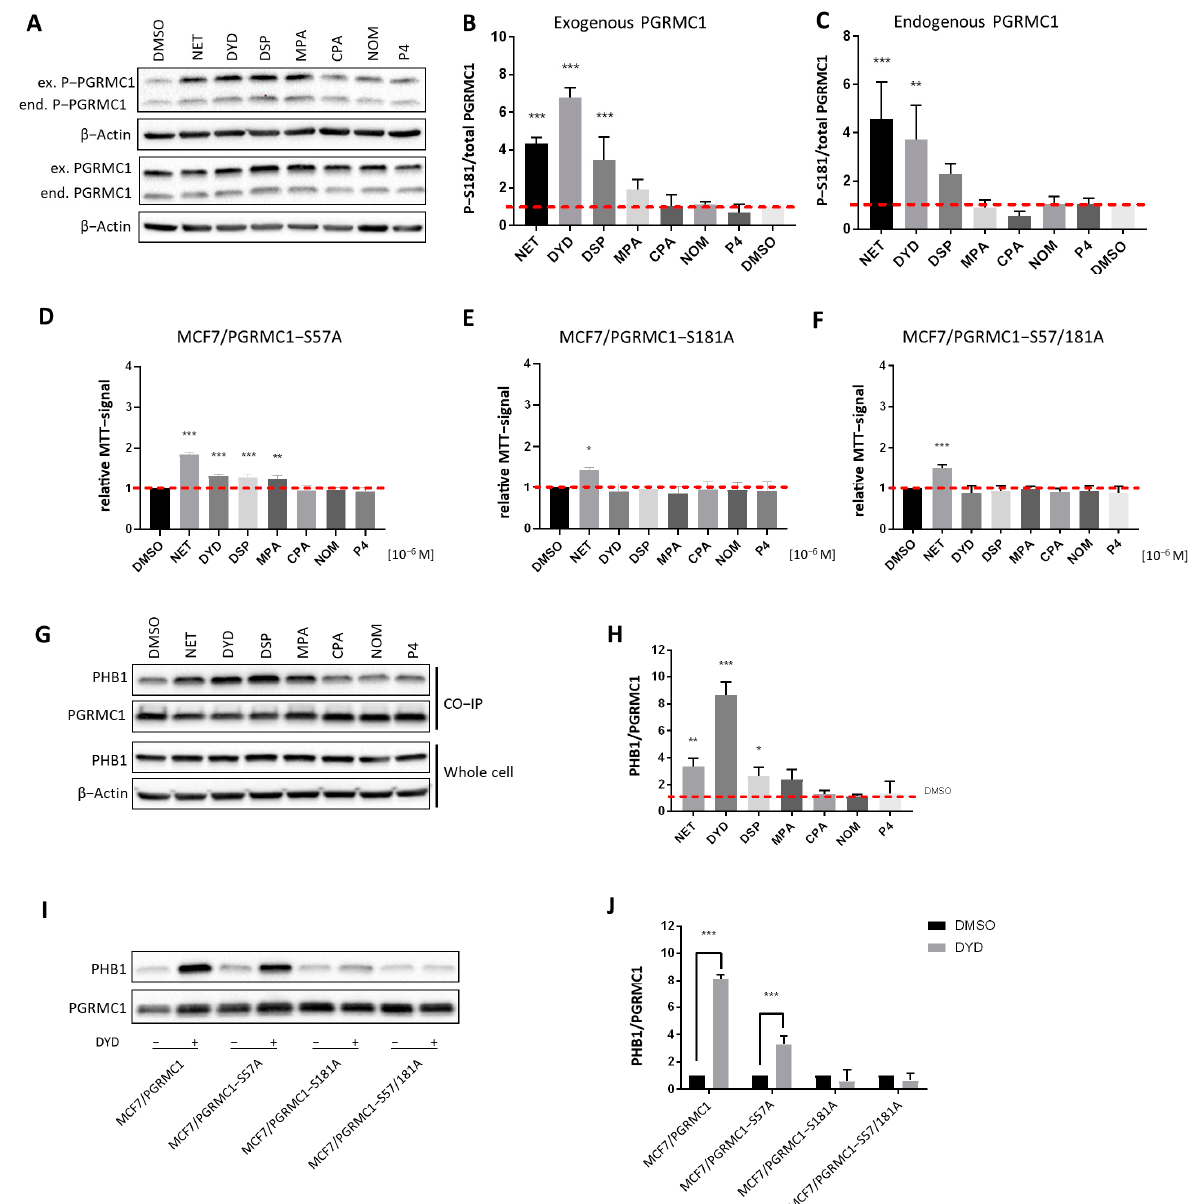
Figure 3. PGRMC1-S181-phosphorylation is essential for increased cell proliferation and PHB binding upon progestin treatment. ( A ) Western blot analysis of PGRMC1-S181-phosphorylation and PGRMC1 protein levels in whole cell lysates of MCF7/PGRMC1 cells after treatment with progestins (10 − 6 M) and DMSO. S181-phosphorylation occurs on both the endogenous PGRMC1 (lower band, ≈ 25 kDa) and exogenous HA-tagged PGRMC1 (upper band, ≈ 28 kDa). Densitometric analysis of Western blot results for S181-phosphorylation of ( B ) exogenous PGRMC1 and ( C ) endogenous PGRMC1 relatively to total PGRMC1 protein level. ( D – F ) Relative MTT signal as surrogate for cell number of ( D ) MCF7/PGRMC1-S57A, ( E ) MCF7/PGRMC1-S181A, ( F ) MCF7/PGRMC1-S57A/S181A cells treated with different progestins (all 10 − 6 M) or DMSO for 72 h. Values were normalized to DMSO treated cells. ( G ) Western blot analysis of immunopurified HA-tagged PGRMC1 and co-precipitated PHB1 from MCF7/PGRMC1 cells treated with different progestins (10 − 6 M) and DMSO (upper panel) and PHB1 protein level in whole cell lysates in the same cells (lower panel). ( H ) Densitometric analysis of co-precipitated PHB1 ( I ) Western blot analysis of immunopurified HA-tagged PGRMC1-variants and co-precipitated PHB1 after treatment with DYD (10 − 6 M) or DMSO. ( J ) Densitometric analysis of co-precipitated PHB1. ( B , C , H , J ) Signal intensity was normalized to corresponding DMSO-control and signal intensity of total PGRMC1 ( B , C ) or each precipitated PGRMC1-variant ( H , J ). Statistical analysis was performed by one-way ANOVA ( A – H ) or two-way ANOVA ( J ) and Bonferroni post-hoc tests. *: p < 0.05, **: p < 0.01, ***: p < 0.001.